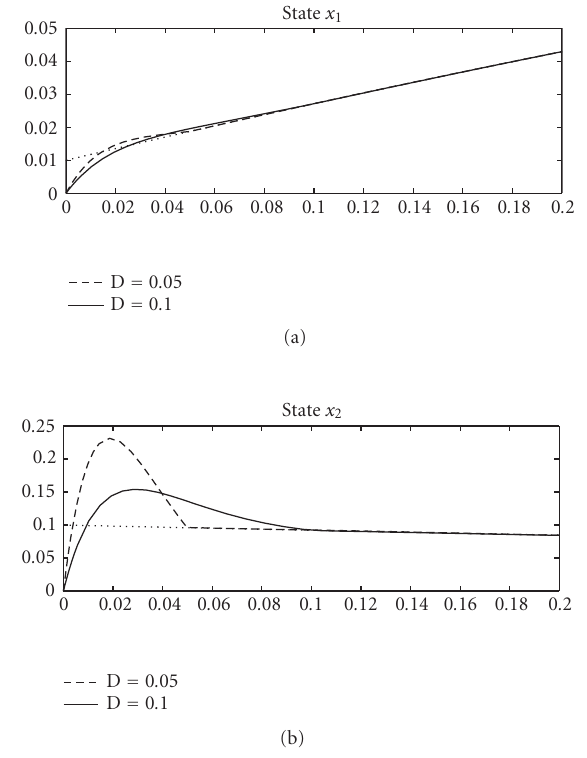
Figure 1: Finite-time estimation with di ff erent convergence time delays, A : D = 0 . 05, B : D = 0 .